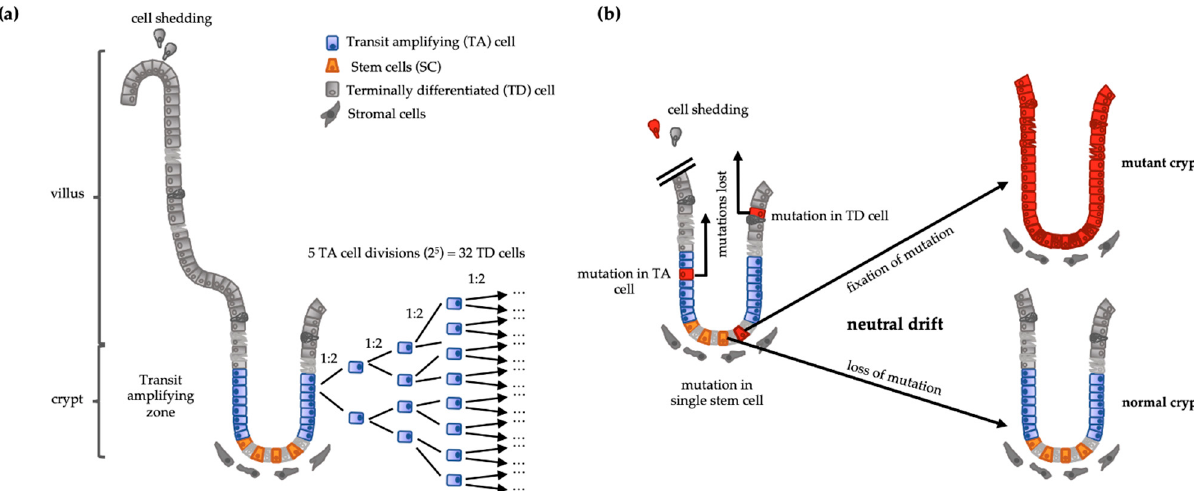
Figure 1. ( a ) Intestinal crypt-villus structure representing the stem cell (SC) function. If a stem cell generates a transit- amplifying (TA) cell and the latter divides 5 times, it will generate 32 (2 5 ) terminally differentiated cells (TD) from a single stem cell division. ( b ) Intestinal cells harboring a mutation in a TA cell or a TD cell are shed and lost. Mutation in a SC gets fixed if the mutated SC dominates TD: Terminally differentiated; SC: stem cells; TA: Transit amplifying.